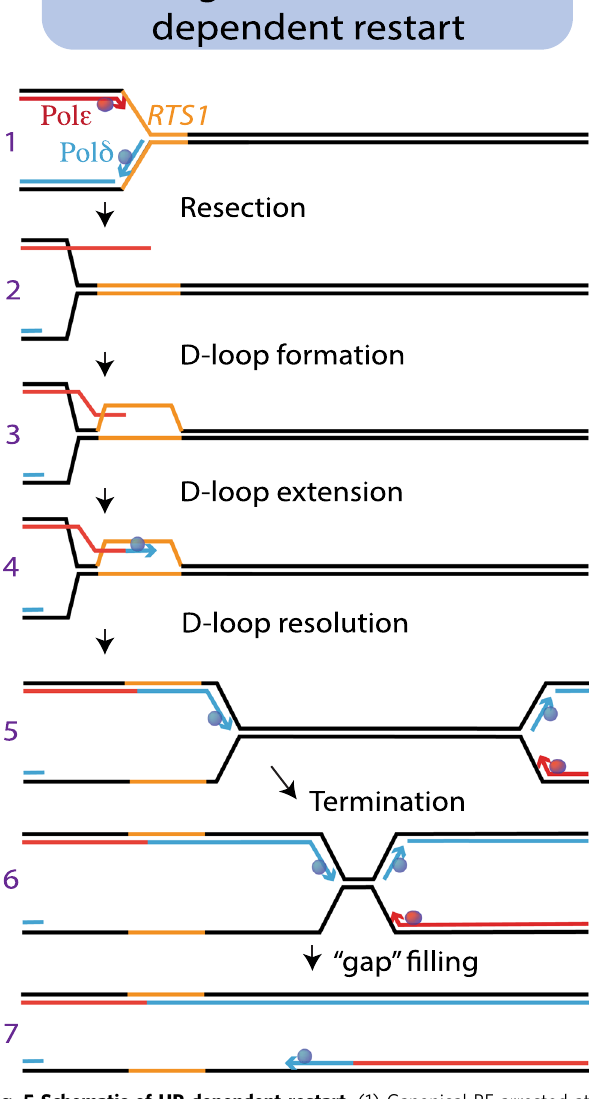
Fig. 5 Schematic of HR-dependent restart. (1) Canonical RF arrested at RTS1 . DNA synthesised by Pol ε is shown in red. DNA synthesised by Pol δ shown in blue. Template: black. RTS1 sequence: orange. (2) Resection generates a free 3 ′ end. (3) Recombination factors generate a D-loop at the site of stalling. (4) The D-loop primer is extended, most likely by Pol δ . The D-loop is resolved, establishing semi-conservative DNA synthesis. (5). Pol δ , with a minimal contribution from Pol α , synthesises the leading strand. DNA synthesis is insensitive to further downstream RTS1 barriers. (6) Termination with the incoming canonical fork. (7). The gap is fi lled by Pol δ